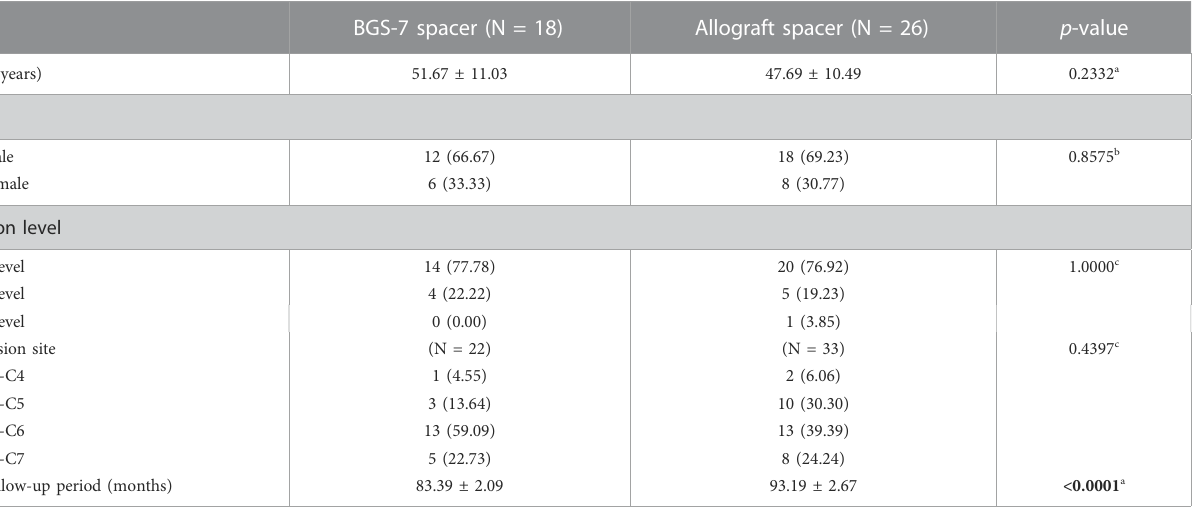
TABLE 3 Demographic data and surgical